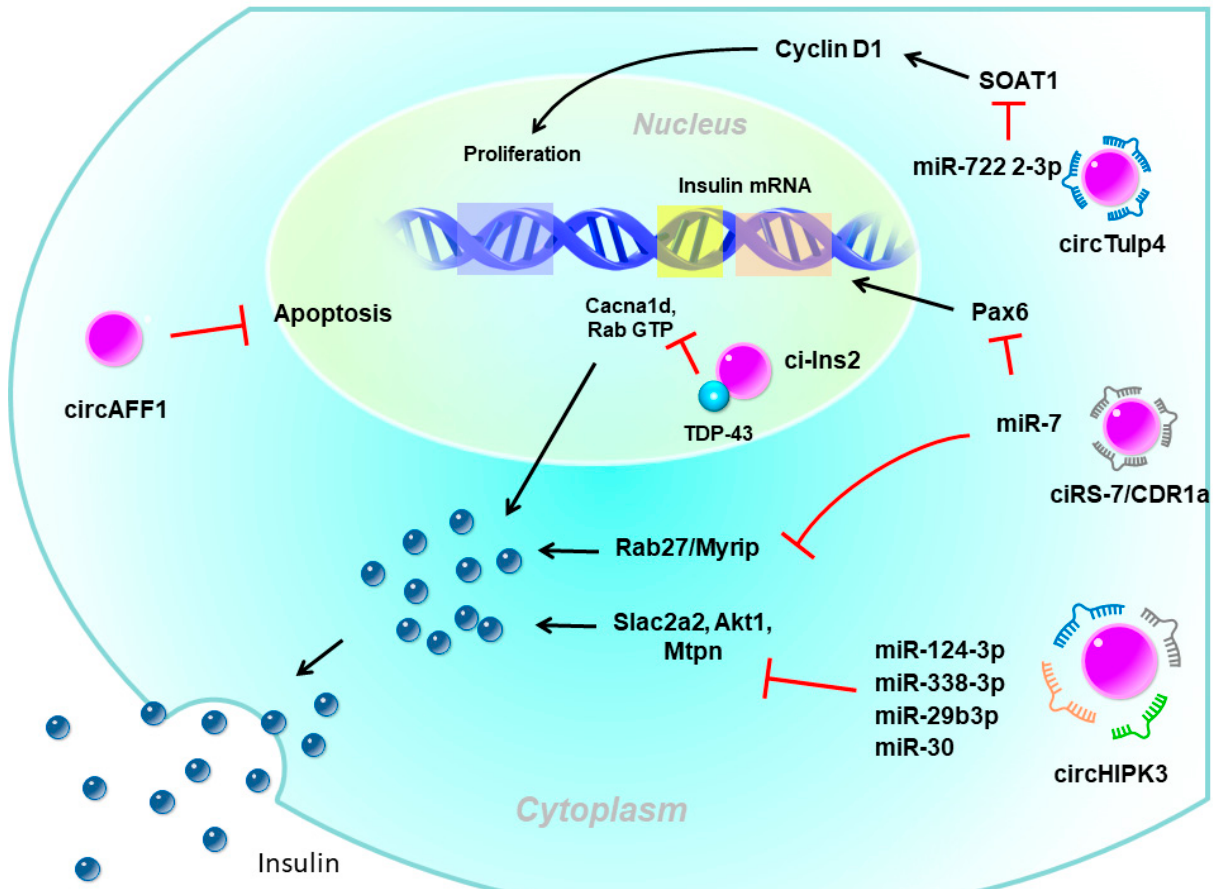
Figure 2. The potential role of circular (circ)RNAs in pancreatic β -cells. circHIPK3 and ciRS-7/CDR1a are exonic circRNAs mainly localized in the cytoplasm which act as miRNA sponges to enhance insulin secretion. ciRS-7/CDR1a also enhances insulin expression by the mi7 sponge. circTulp4 is also an exonic circRNA that sequesters miR-7222-3p to promote β -cell proliferation. circAFF1 is an exonic circRNA that inhibits β -cell apoptosis through an unknown mechanism. ci-Ins2 is an intronic circRNA mainly localized in the nucleus that interacts with the RNA-binding protein, TDP-43. The interaction between ci-Ins2 and TDP-43 promotes expression of the insulin secretory machinery. Pax6, paired box 6; SLc2a2, solute carrier family 2 member 2; Akt1, AKT serine/threonine kinase 1; Mtpn, myotrophin; Myrip, myosin VIIA and Rab interacting protein; Cacna1d, calcium voltage-gated channel subunit alpha1 D; TDP-43, TAR DNA-binding protein 43.